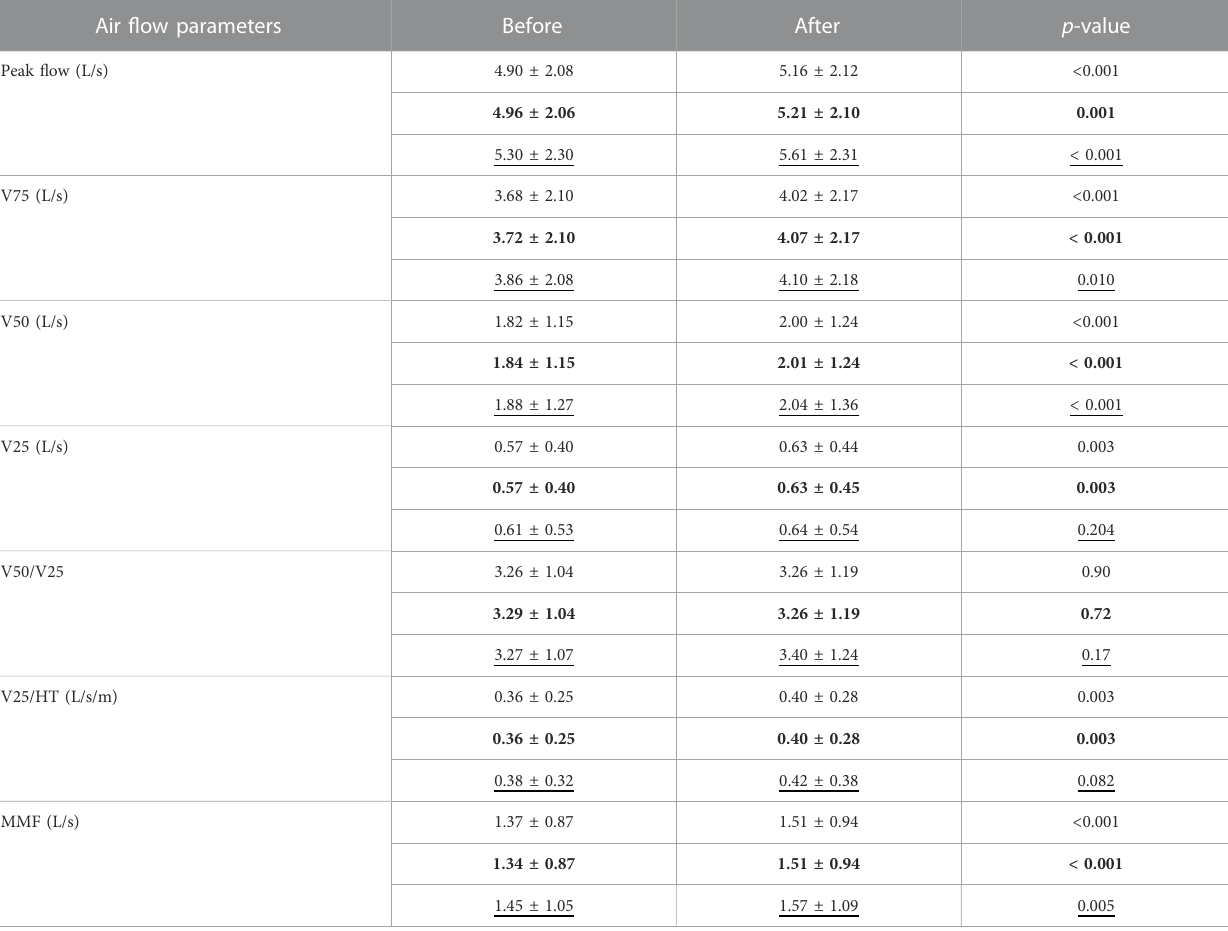
TABLE 1Changesin air fl owdata bythe (switching) use ofFF/UMEC/VI200/62.5/25 μ gandcomparisonbetweenFF/UMEC/VI200/62.5/25 μ gandFF/VI200/25 μ g. Air fl ow parameters Before